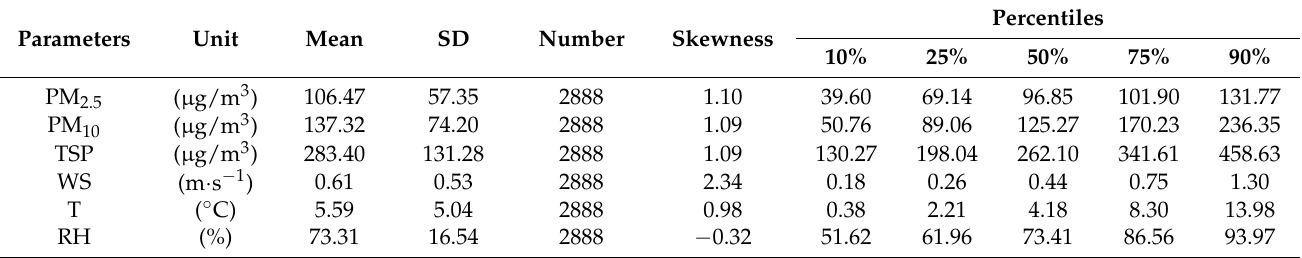
Table 2. Statistics of each variable of particulate matter and meteorology parameters during the experimental